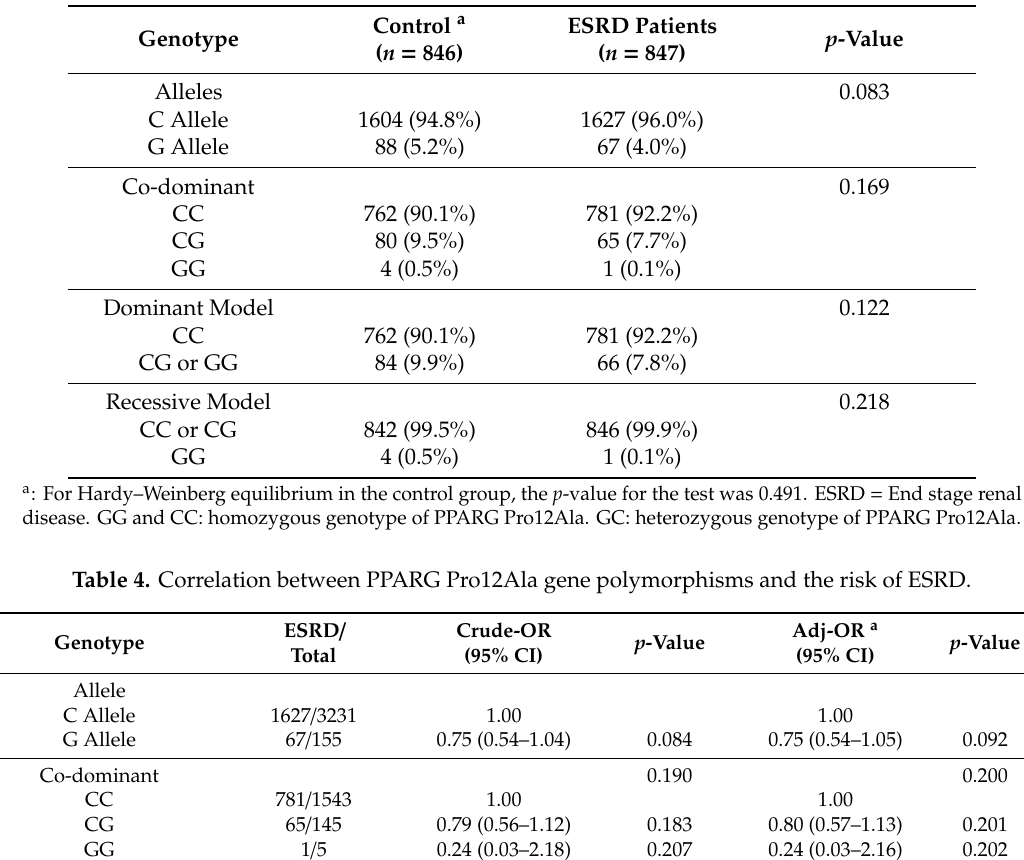
Table 3. PPARG Pro12Ala genotype distribution in ESRD case and control groups.